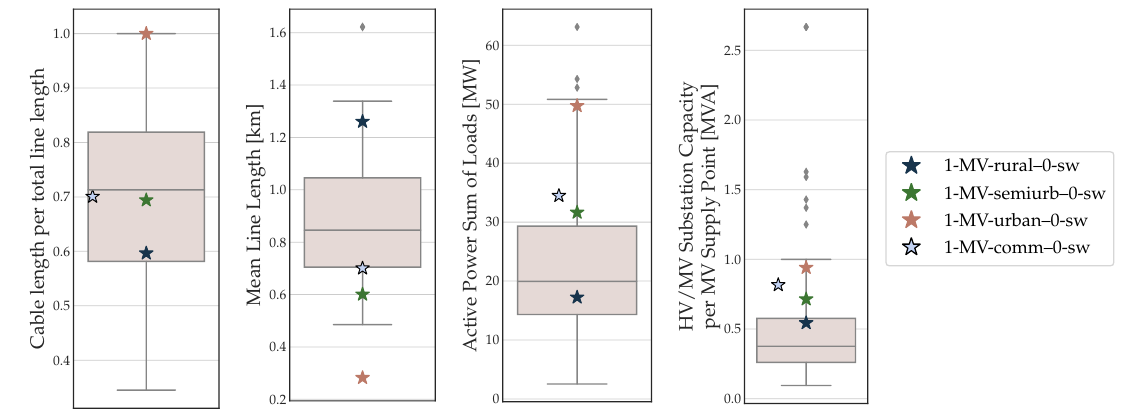
Figure 6. Statistical comparison of parameters of real MV grids (boxplots) and SimBench MV grids; The horizontal axis are only introduced to avoid